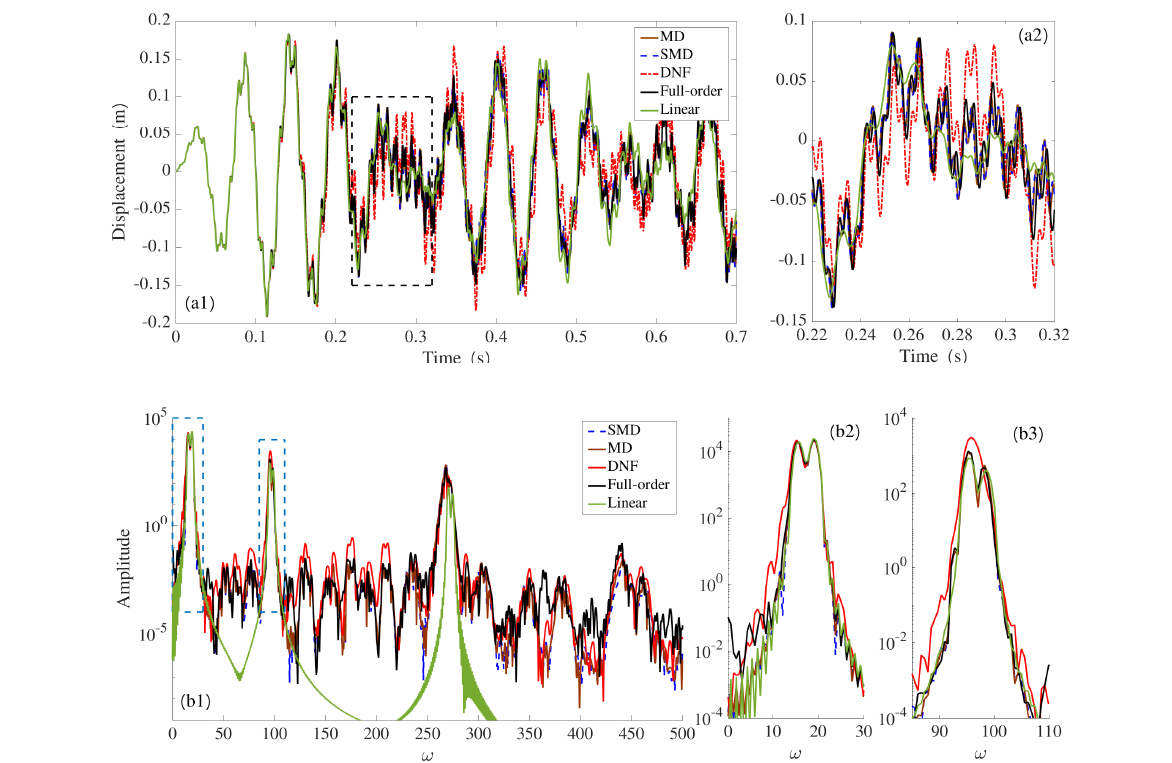
Figure 15. Vibration response of the cantilever beam to a concentrated force applied at the tip, with an amplitude of 400 N and temporal content of f ( t ) = sin ( 1.21 ω 1 t ) + sin ( 0.97 ω 3 t ) + sin ( 0.98 ω 5 t ) . ( a1 ) Full view of the time response in the first 0.7 s; ( a2 ) close-up view. ( b1 ) Fourier spectrum of the vibration up to 500 Hz; ( b2 , b3 ) close-up views of the first frequency peak (mode 1) and the second frequency peak, corresponding to mode 3. The reference solution compared to three different ROMs built with three modes is shown in black: blue: QM–SMD, brown: QM–MD, red: DNF. Full-order model with linear restoring force is shown in